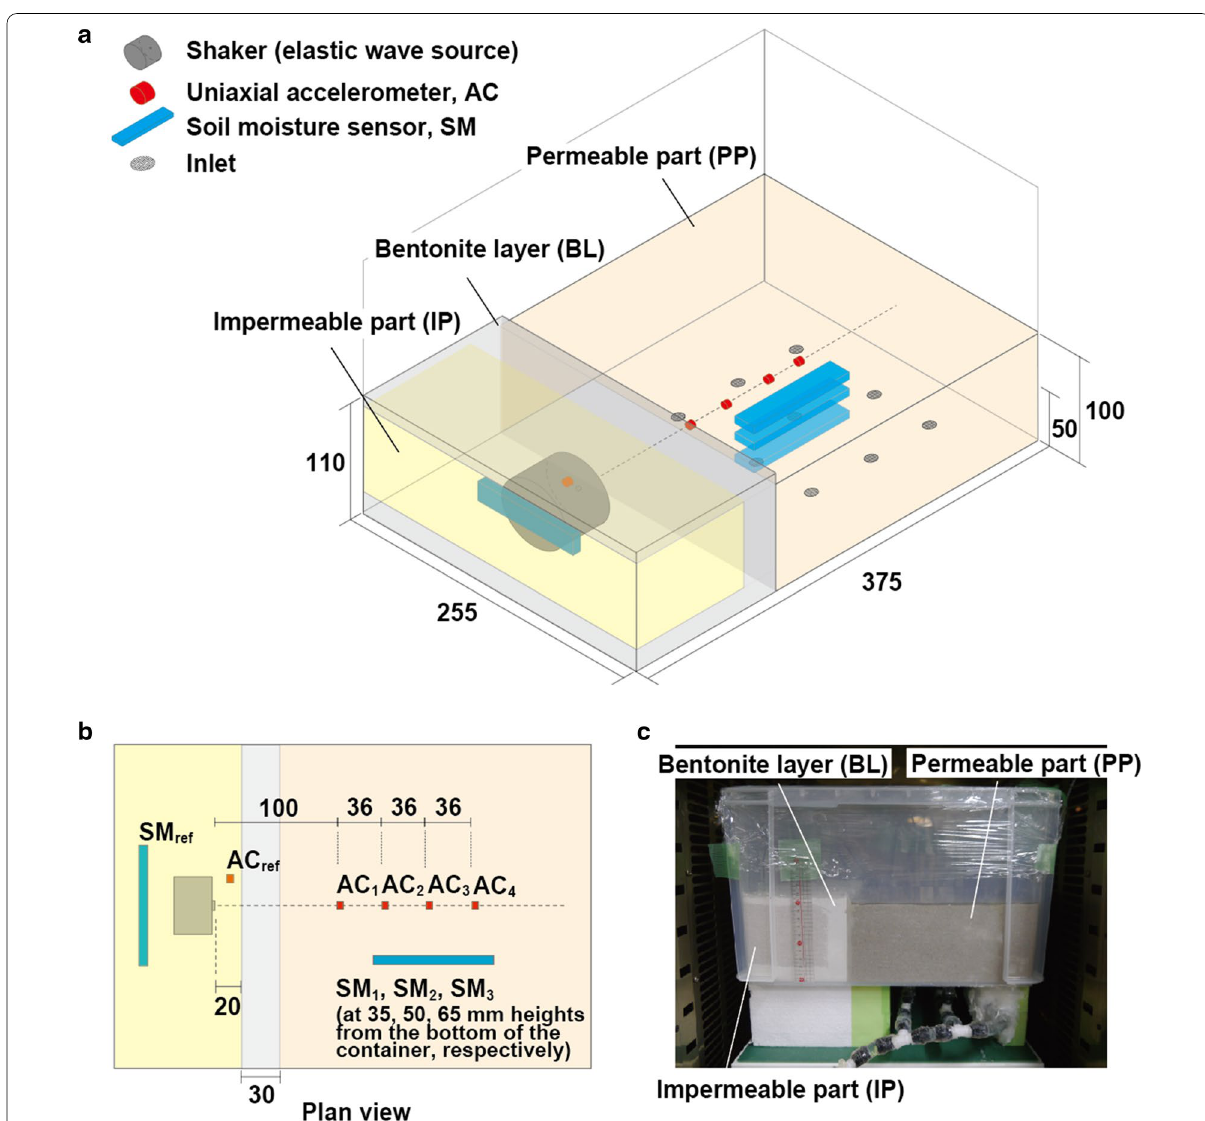
Fig. 2 a Schematic illustration of the sand and b plan view. The scales are in millimeters. c Photo of the apparatus under nearly saturated